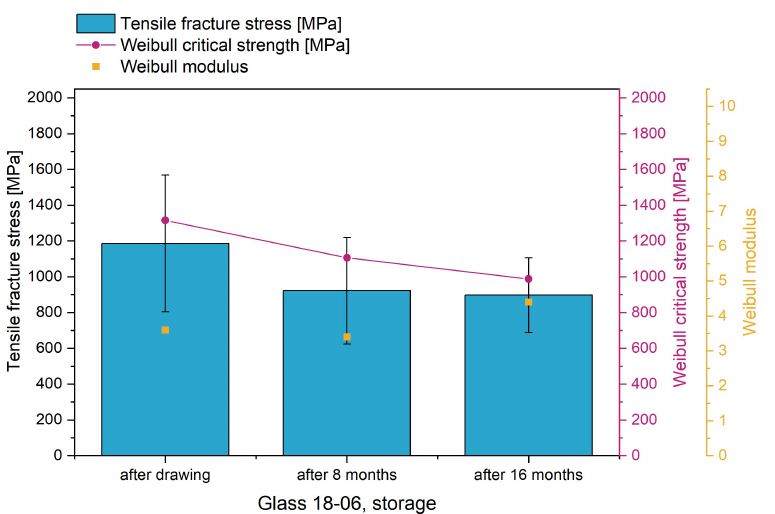
Figure 12. Decrease of the tensile strength of glass 18-06 during storage in a